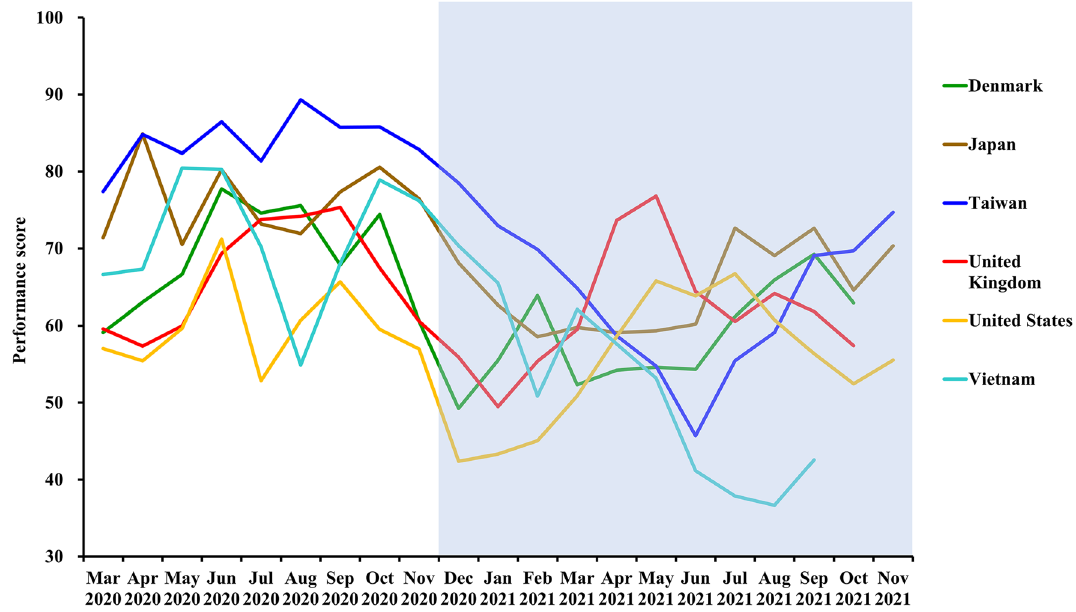
Figure 1. Performance scores of six countries analyzed from March 2020 to November 2021. A vaccination indicator was available only from December 2020 to November 2021 (shaded area). The calculation criteria include Google Trends data (i.e., health literacy and psychological impacts indexed by insomnia). Score range, 0–100, with 0 being the worst containment